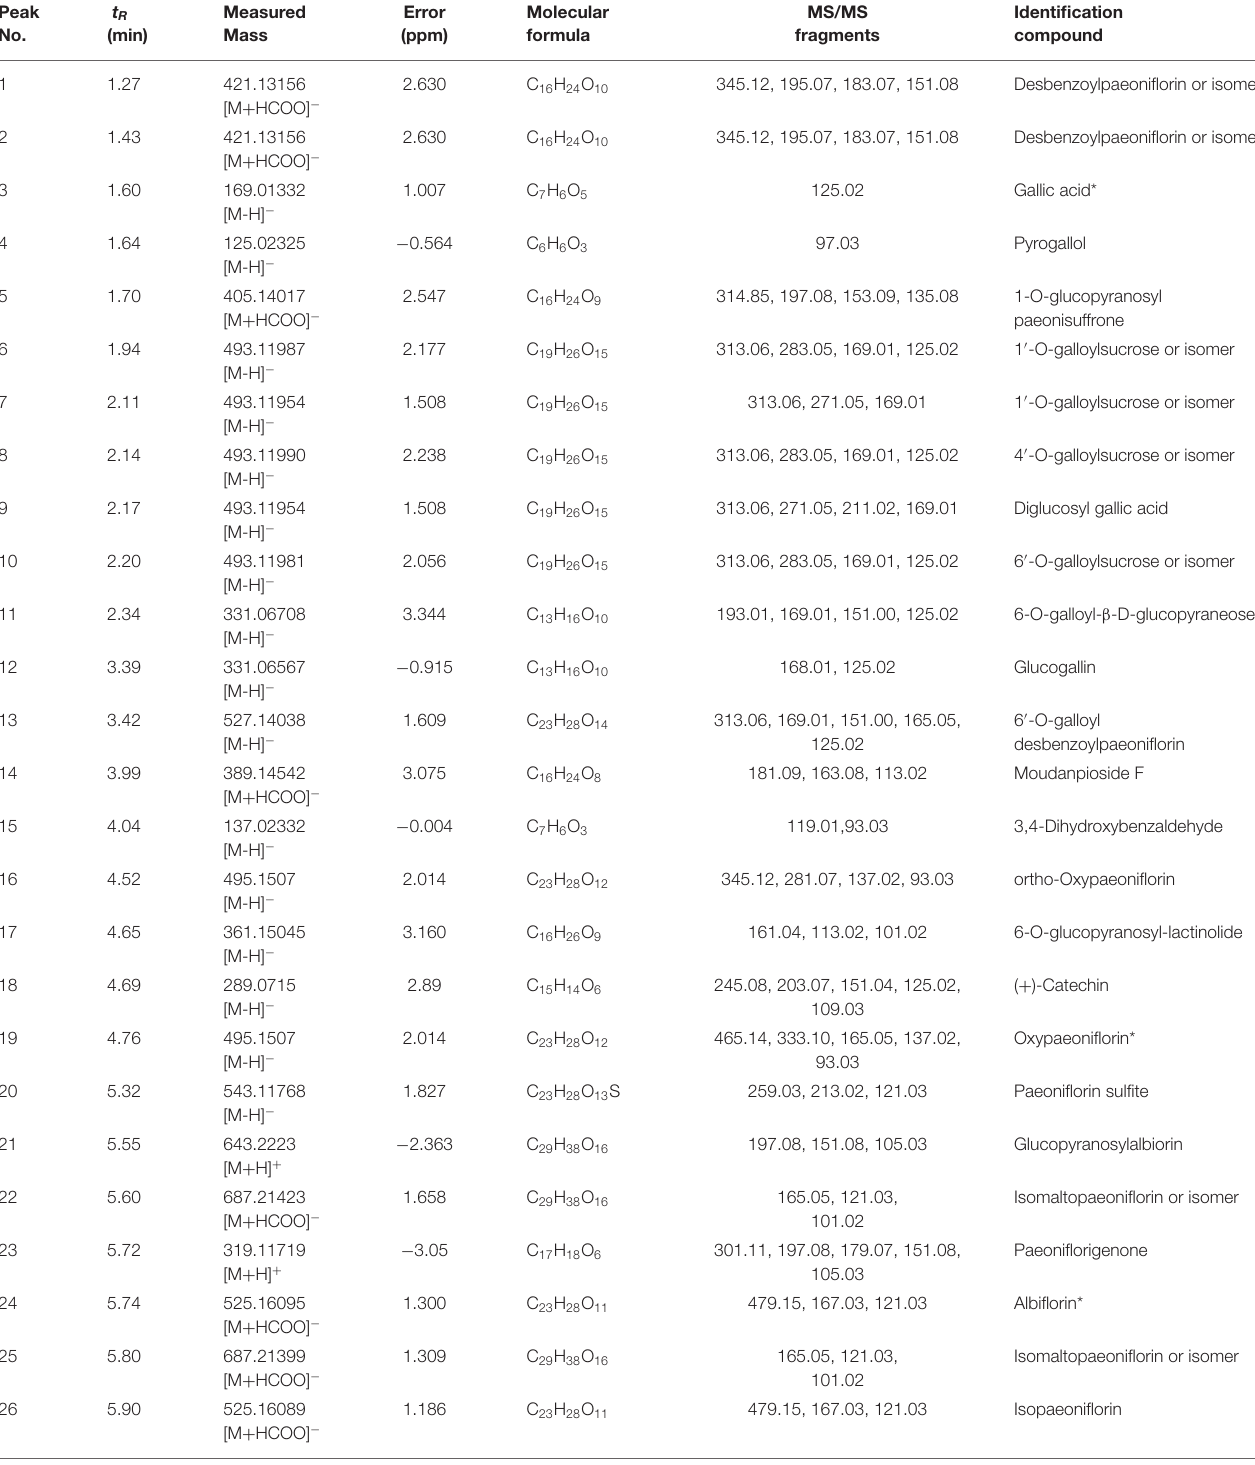
TABLE 1 | Identification of components in PRA by UPLC-Q Exactive Orbitrap HRMS. Peak